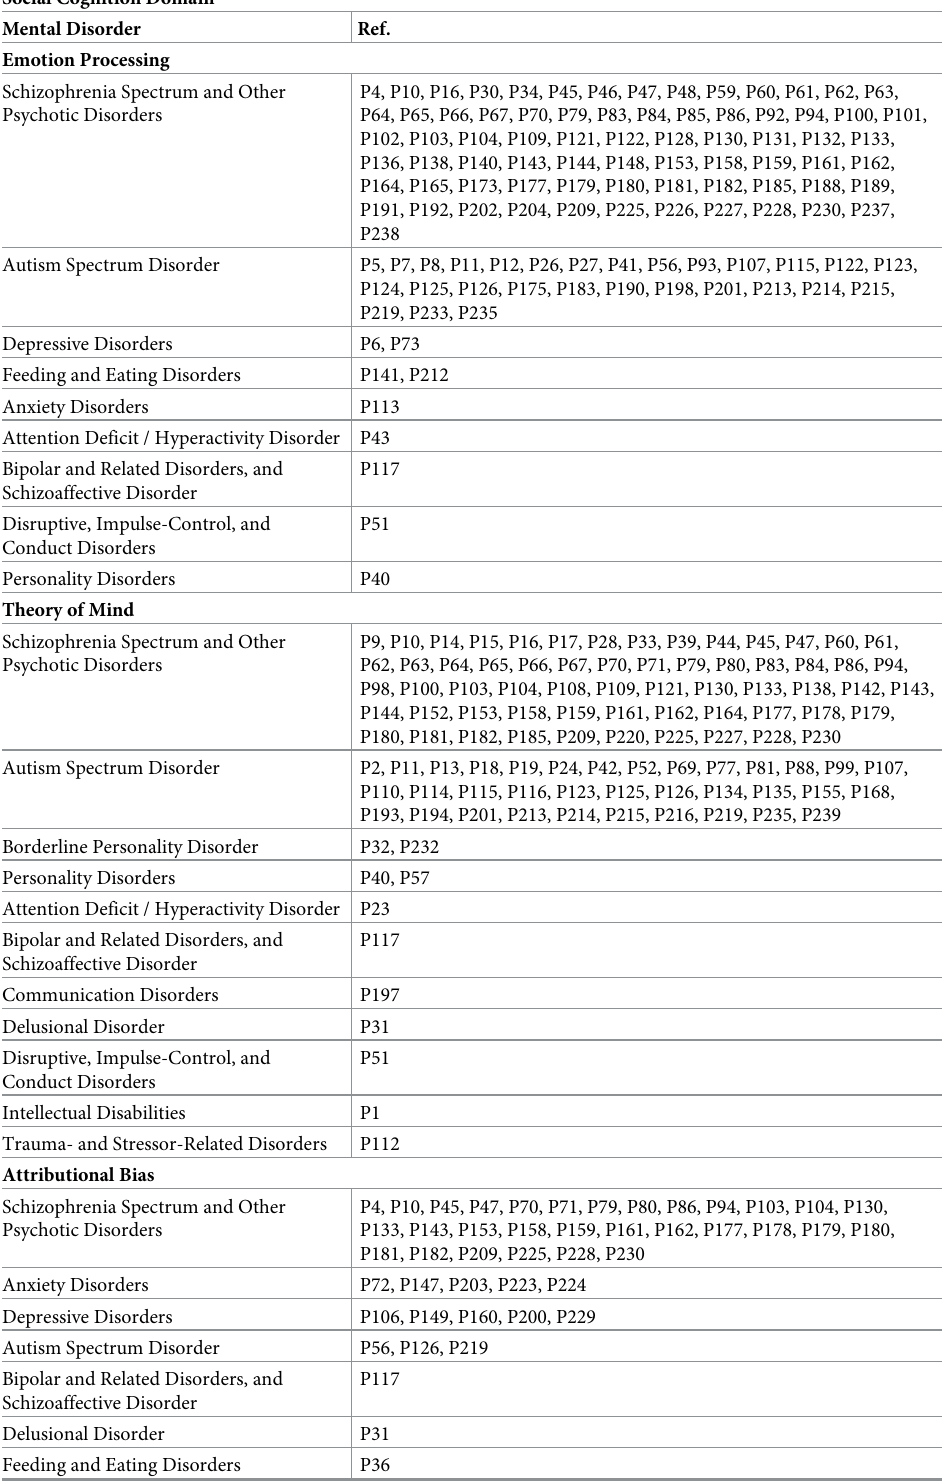
Table 3. Mental disorders for each domain in social